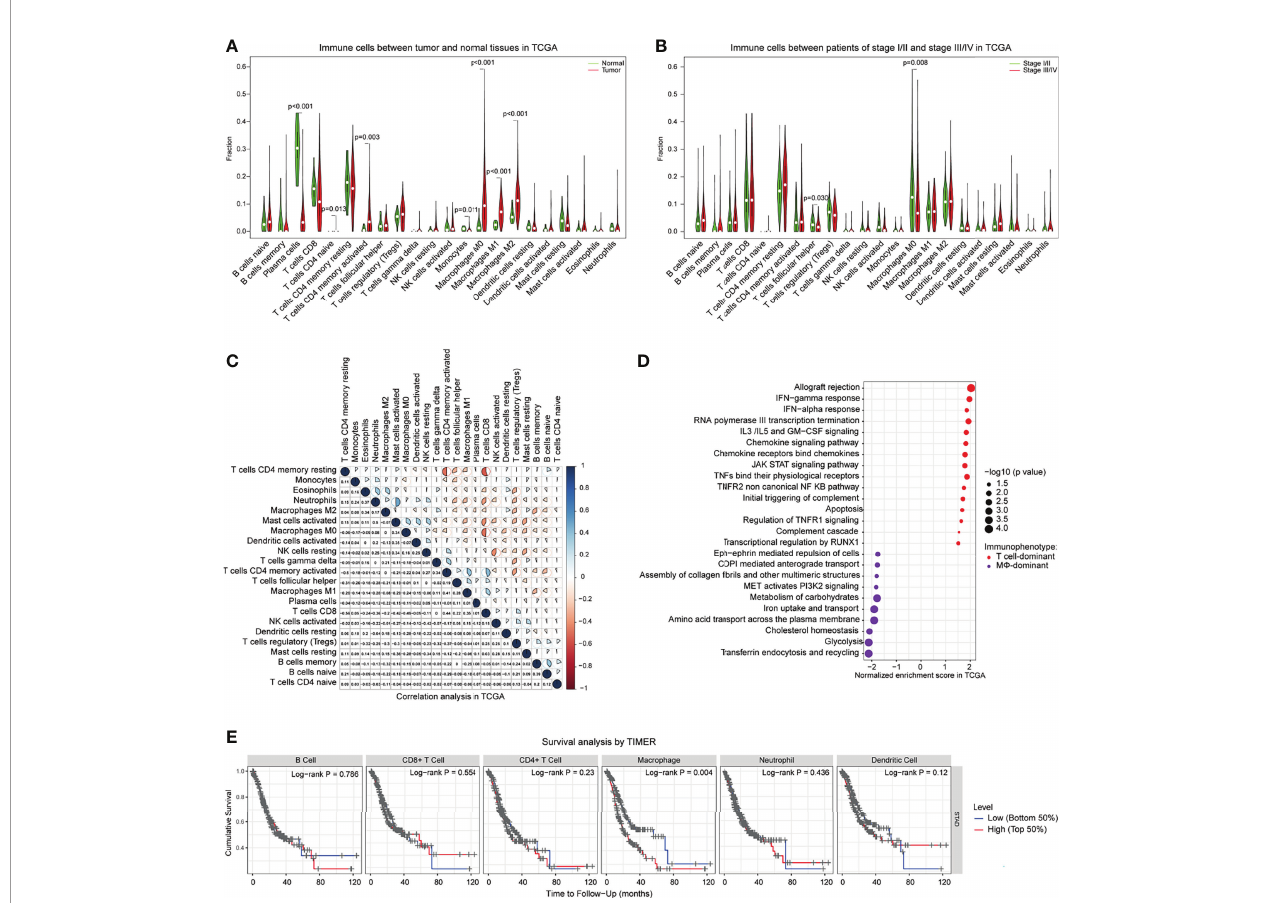
FIGURE 5 | Genomic traits of GC-determined immunophenotypes and clinical information in TCGA. (A) Comparisons of the 22 immune cells de fi ned by CIBERSORT between tumor and adjacent normal tissues of GC patients for all eligible samples in TCGA. (B) Comparisons of the 22 immune cells between GC patients with stage I/II and stage III/IV in TCGA. (C) Correlation of various immune cells de fi ned by CIBERSORT in TCGA. (D) Selected pathways related to the T cell-dominant immunophenotype (T cells/macrophages ≥ 1) and macrophage-dominant immunophenotype (T cells/macrophages <1) by GSEA. Pathways for which |NES|>1, p < 0.05, are chosen to be shown. The position of each circle represented the normalized enrichment score of immunophenotype in which the upregulated pathway is detected in GC patients. The size of the circles represents -log10 ( P -value). (E) Kaplan – Meier curve showing the overall survival based on the level of various immune cells by TIMER. GSEA, gene set enrichment analysis; NES, normalized enrichment score; TIMER, tumor immune estimation